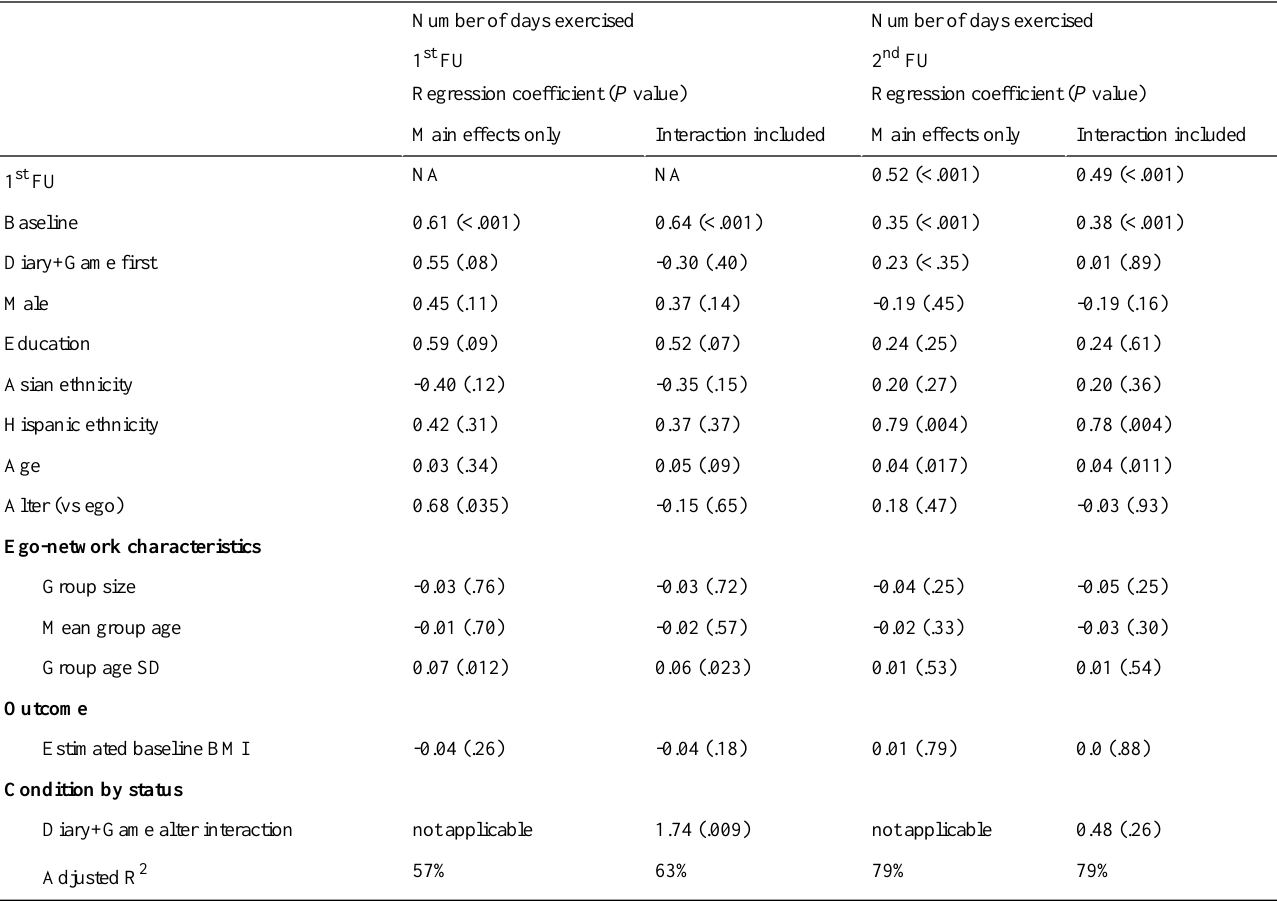
Table 3. Random effects regression coefficients on number of days per week exercised at FU.